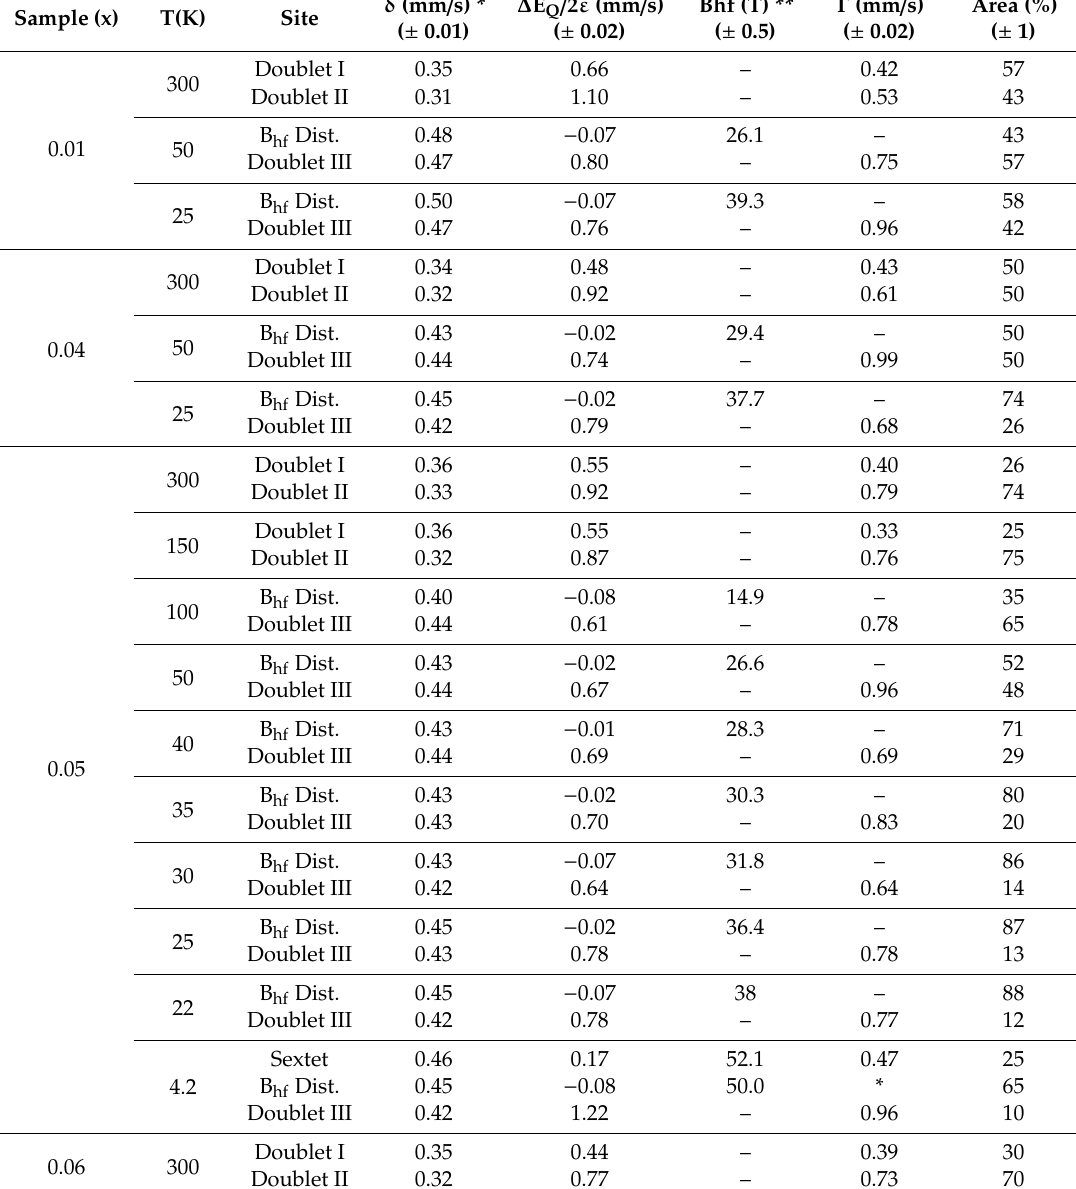
Table 3. Hyperfine parameters and subspectral areas for the Zn 1-x Fe x O samples recorded at di ff erent